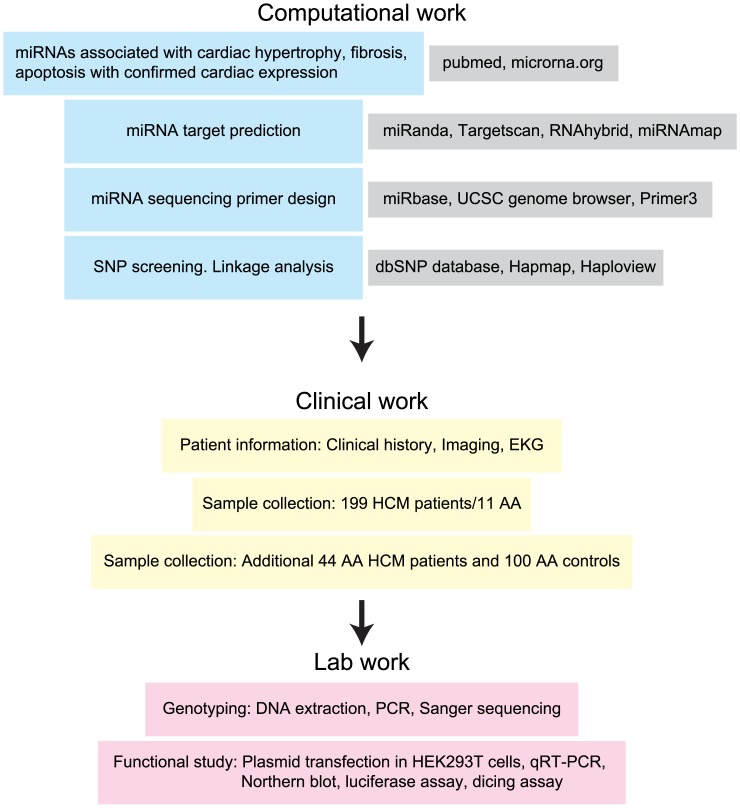
Overall study design.